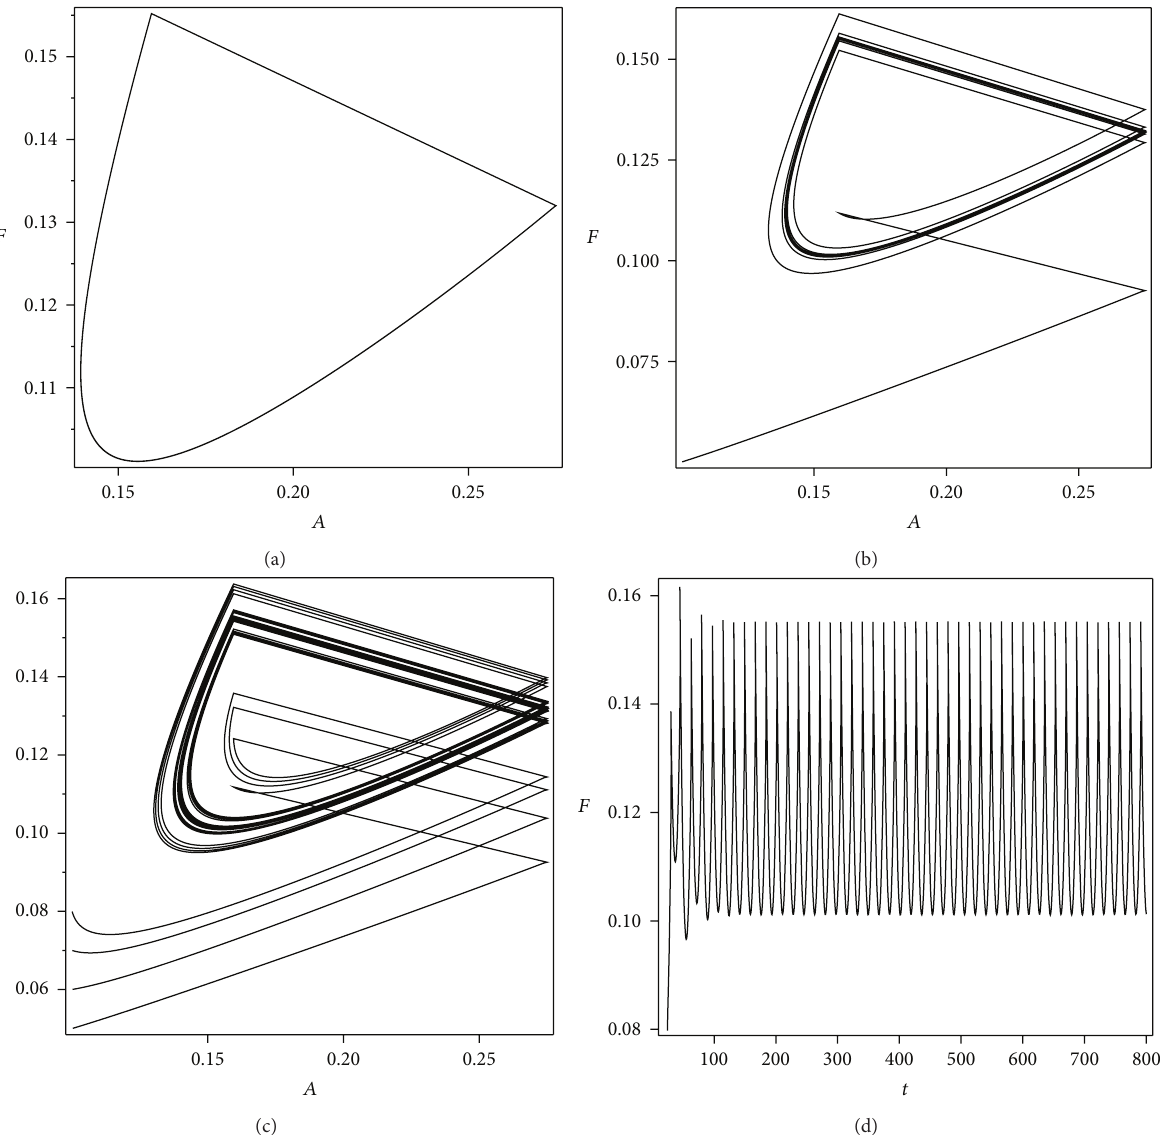
Figure 5: (a) an order-1 periodic solution of system (1); (b) a trajectory with the initial point (0.02, 0.01) in system (1), and the trajectory is attracted by an order-1 periodic solution; (c) several trajectories with different initial point in system (1), and these trajectories are attracted by the same order-1 periodic solution; (d) the time series of system (1) corresponding to (b).